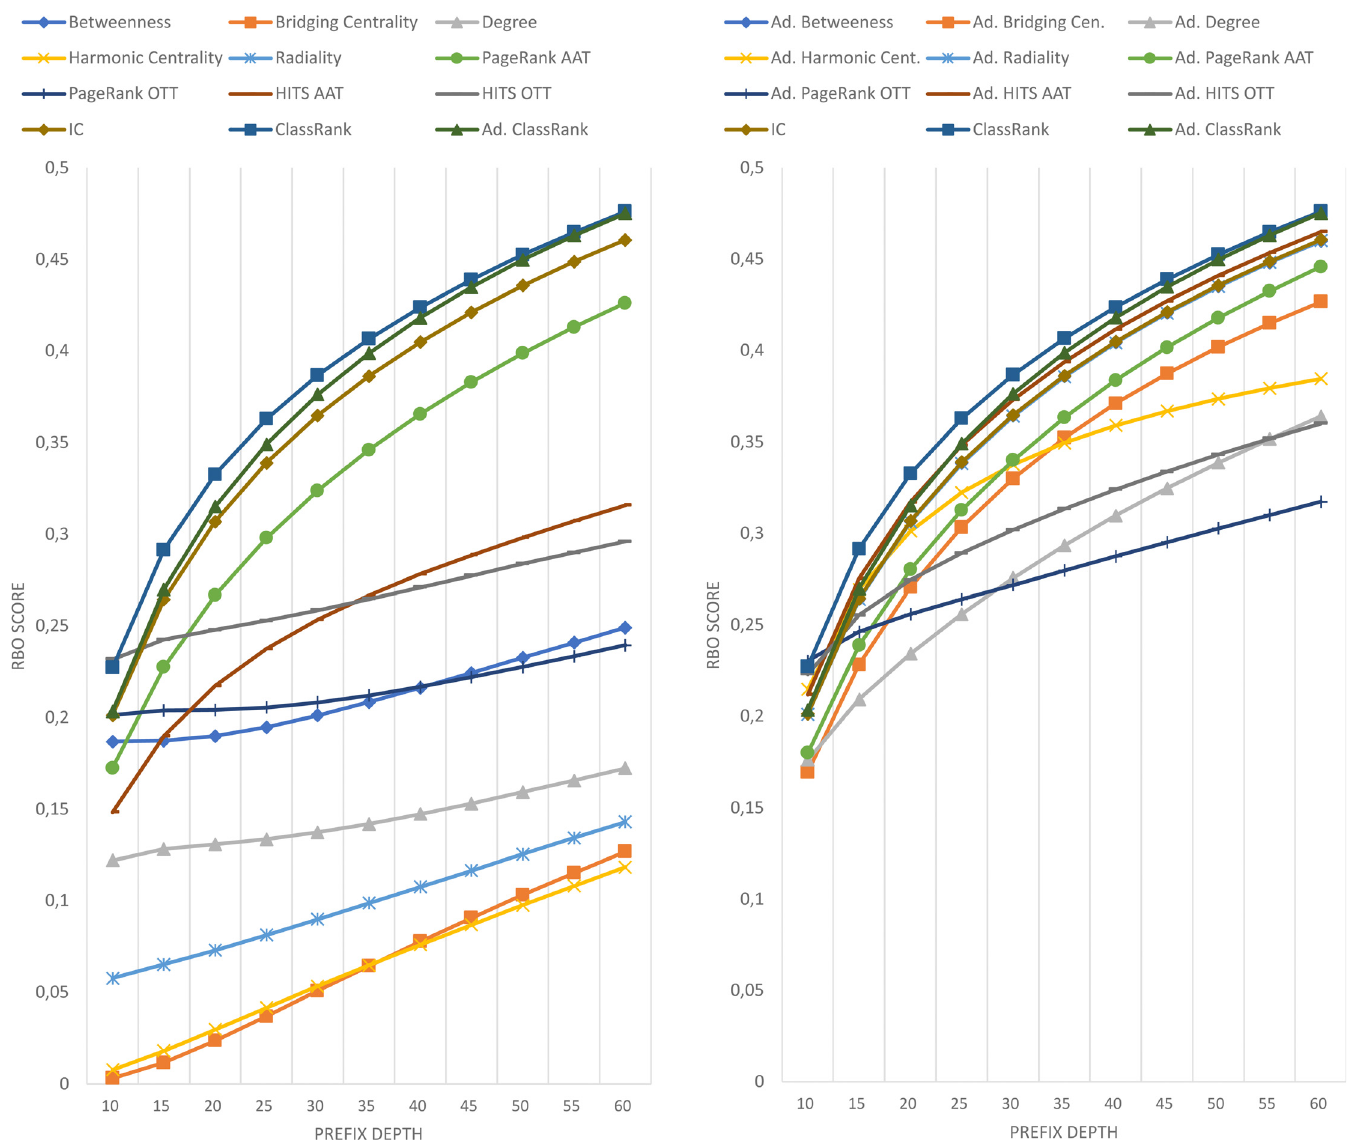
Fig 2. Comparison of techniques against HH log in